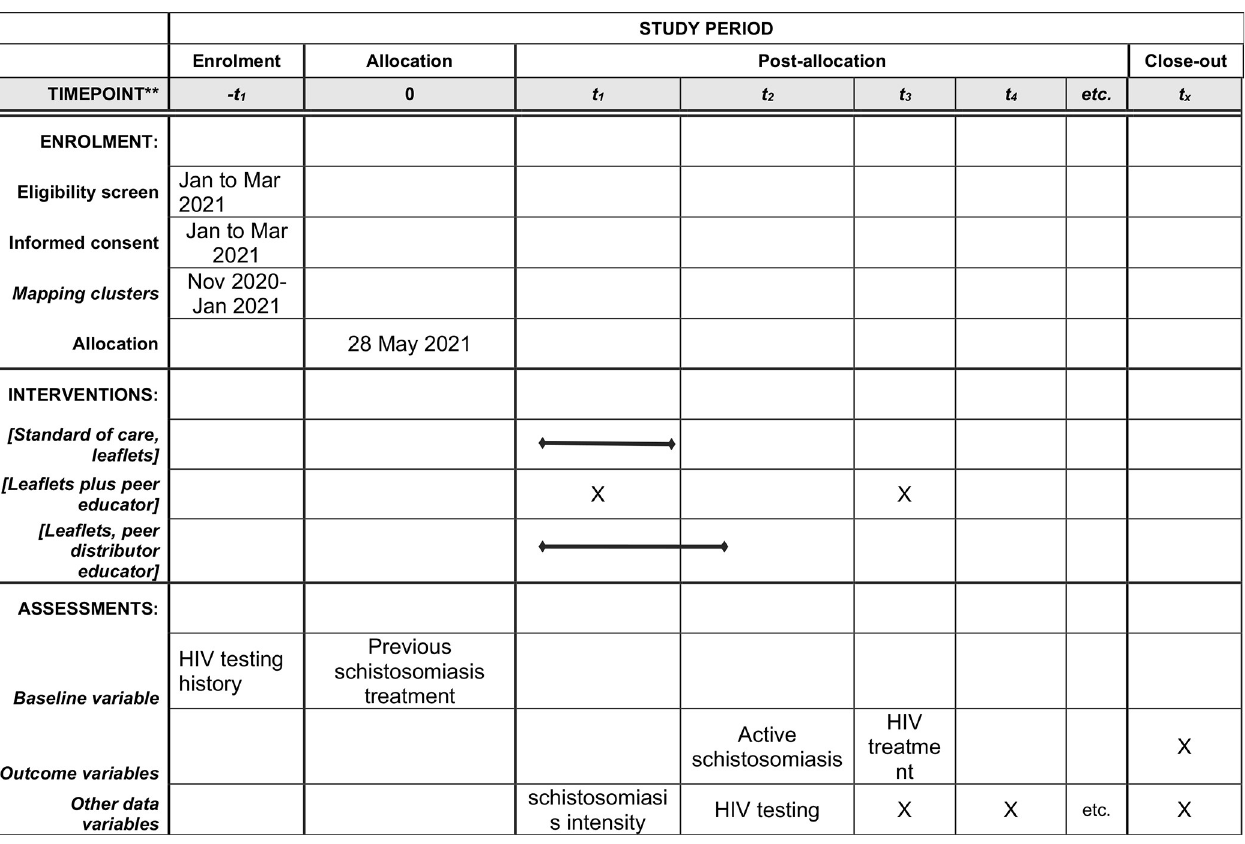
Fig 1. SPIRIT figure summarizing trial